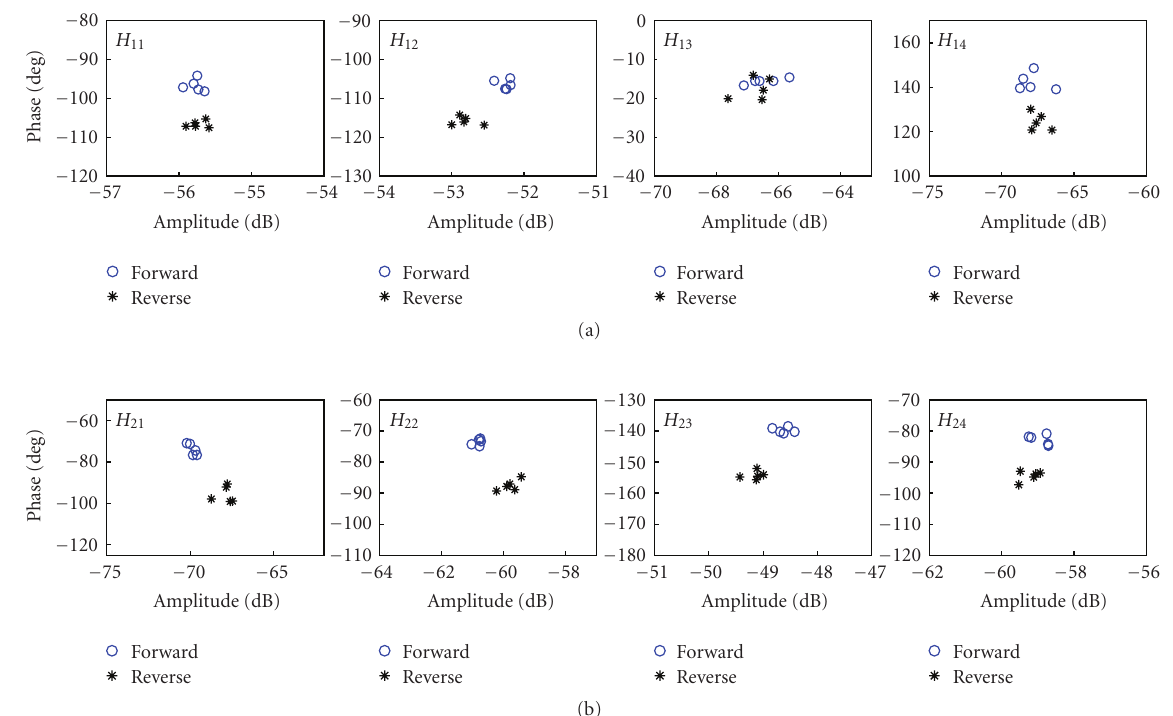
Figure 3: Example of forward and reverse channels measured at Location 4.